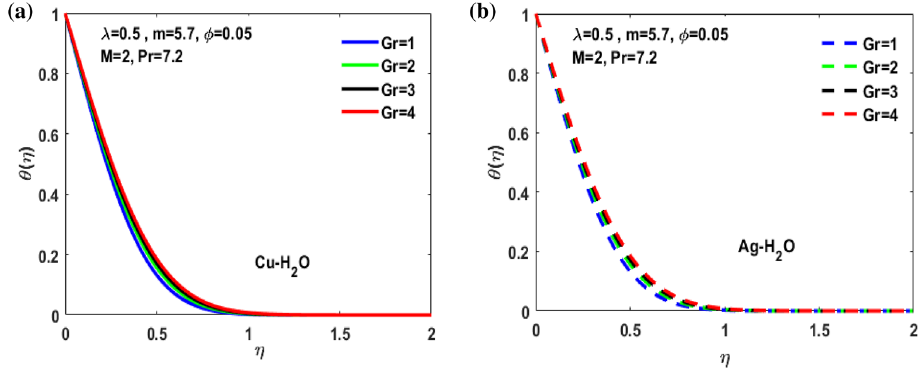
Figure 12. ( a ) Impact of Gr on θ(η) . ( b ) Impact of Gr on θ(η)